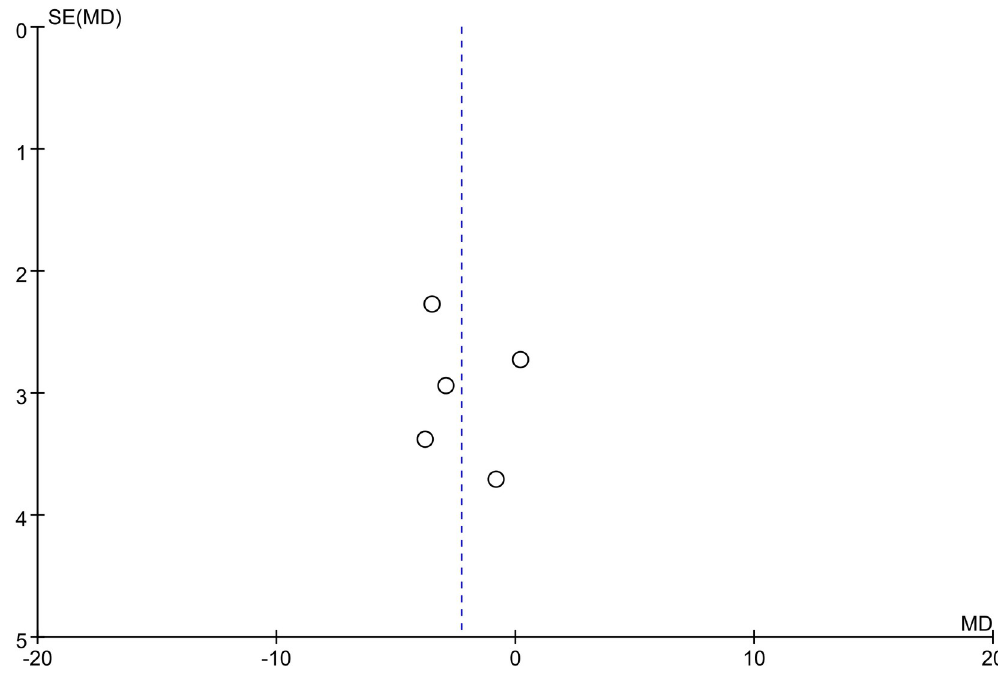
Fig 5. Funnel plot for outcomes of changes in systolic blood pressure.